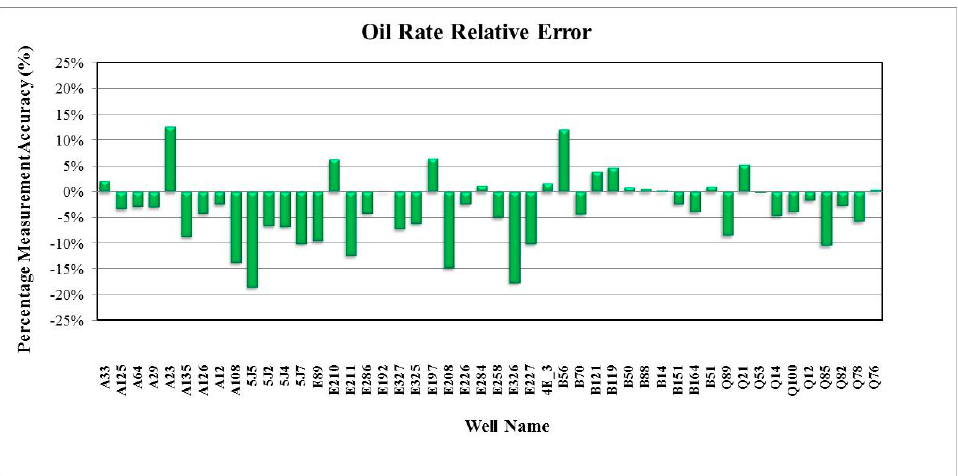
Figure 17. Oil rate measurement accuracy using the Blasius correlation.